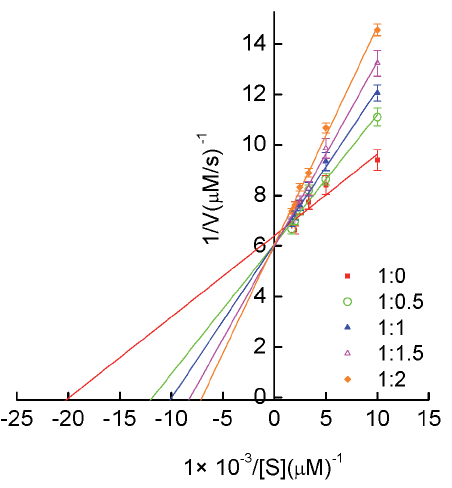
Figure 6. Lineweaver-Burk plots of reaction velocity versus substrate concentration for enzyme kinetics of HSA in absence and presence of HA. The molar ratio of HSA:HA examined are 1:0, 1:0.5, 1:1, 1:1:5, and 1:2.